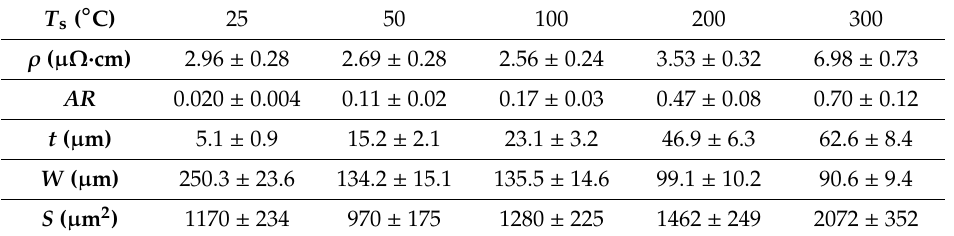
Table 2. Parameters of the aerosol jet printing process to establish the e ff ect of the number of print layers N and the temperature of the heated substrate T s on the characteristics of the lines